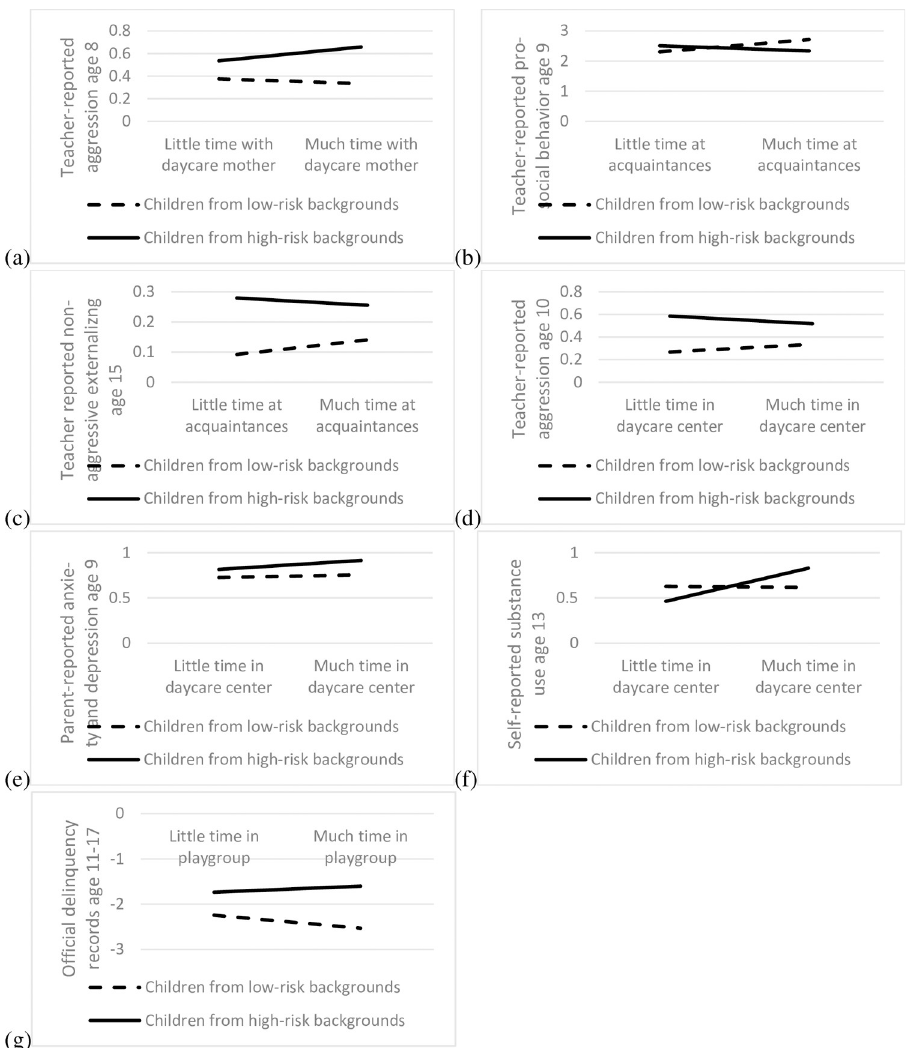
Fig 3. Examples of interactions between external childcare, risk, and social